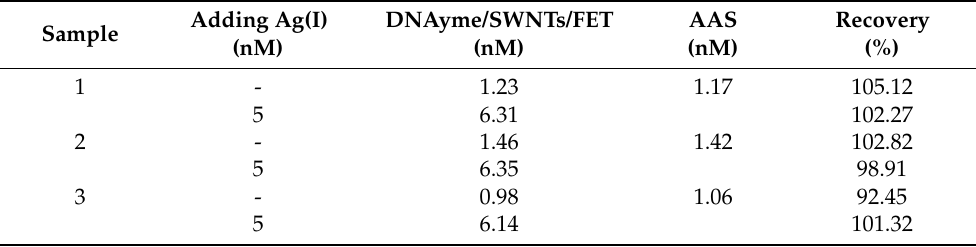
Table 2. Ag + analysis of the Agzyme/SWNTs/FET in river water sample. Reproduced with permis- sion from [120]. Copyright 2018